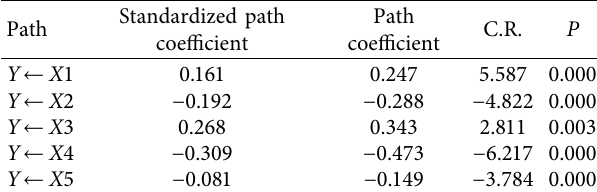
Figure 3 after model initial fitting, adjustment, and